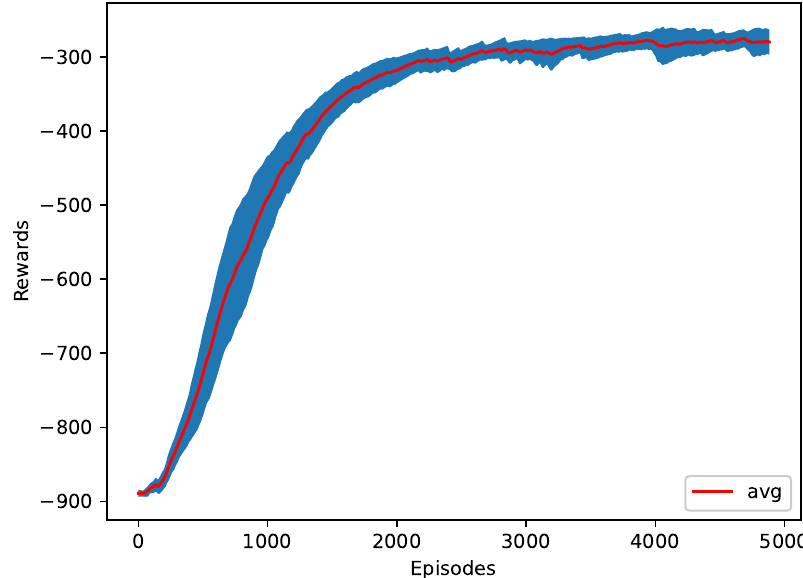
Figure 9. The training plot of the energy as a reward function.